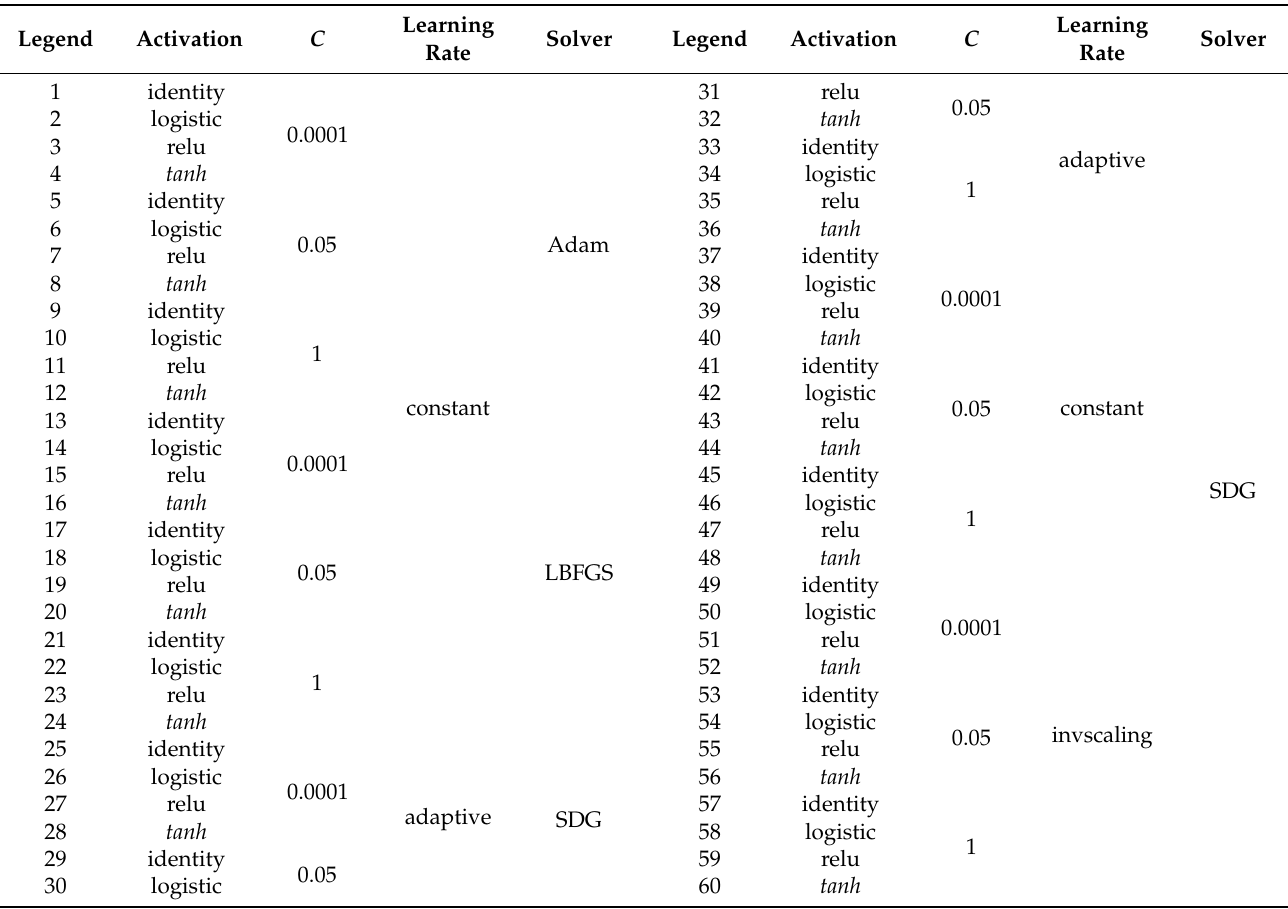
Table A1. Configuration sets of the model hyperparameters for the inner layer architecture for the MLP-ANN